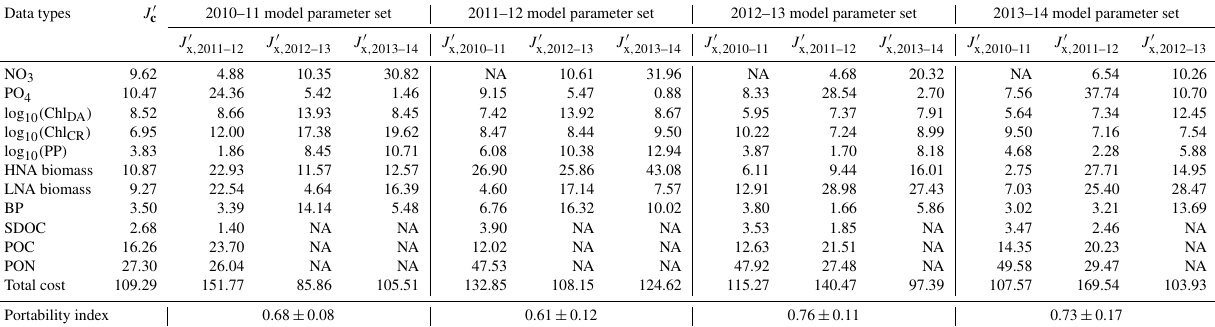
Table 3. Cross-validation cost and portability index. J (cid:48) c is the normalized optimized cost from the climatological model (equivalent to J (cid:48) under the climatological model parameter set in Table 2), and J (cid:48) x is the normalized cross-validation cost (Eq. 5), in which, for example,